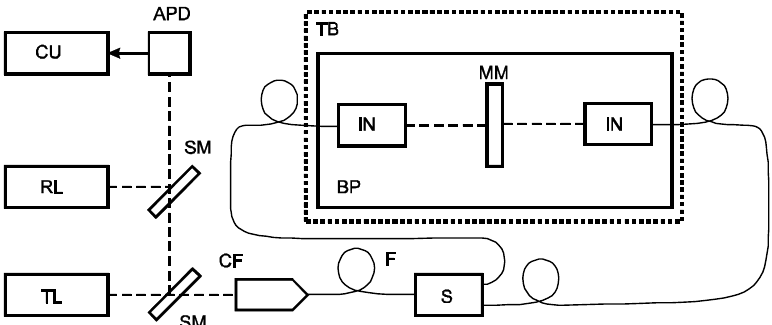
Figure 3. Arrangement of the interferometers with fiber-optic light delivery system monitoring laser frequency detuning by comparison with the reference laser. TL: tunable He-Ne laser, RL: reference stabilized He-Ne-I laser, CU: counter, APD: avalanche 2 photodetector, SM: semireflecting mirror, CF: fiber collimator, F: single-mode polarization maintaining fiber, S: fiber splitter, TB: box with controlled temperature, MM: movable mirror, IN: interferometer, BP: